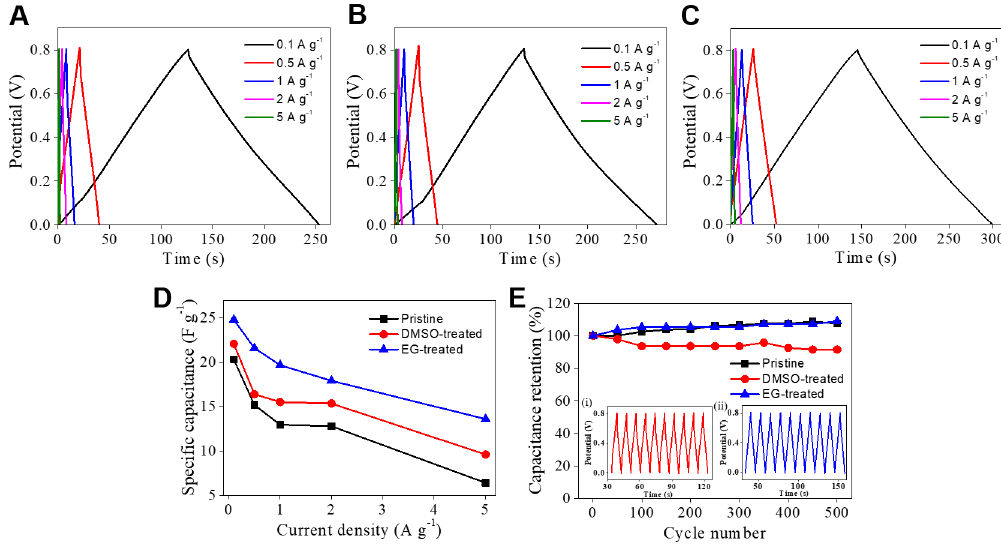
Figure 6. ( A – C ) Galvanostatic charge–discharge (GCD) curves of PEDOT:PSS/CNF composite paper samples treated with ( B ) DMSO and ( C ) EG or ( A ) without solvent post-treatment. The mass of all composite paper samples was 1.0 mg. ( D ) Current density-dependent specific capacitance of PEDOT:PSS/CNF composite paper samples. ( E ) Cycle stability of PEDOT:PSS/CNF composite paper samples at 2 A g − 1 . The inset shows 10 cycles of charge–discharge curves of PEDOT:PSS / CNF composite paper post-treated with (i) DMSO or (ii)